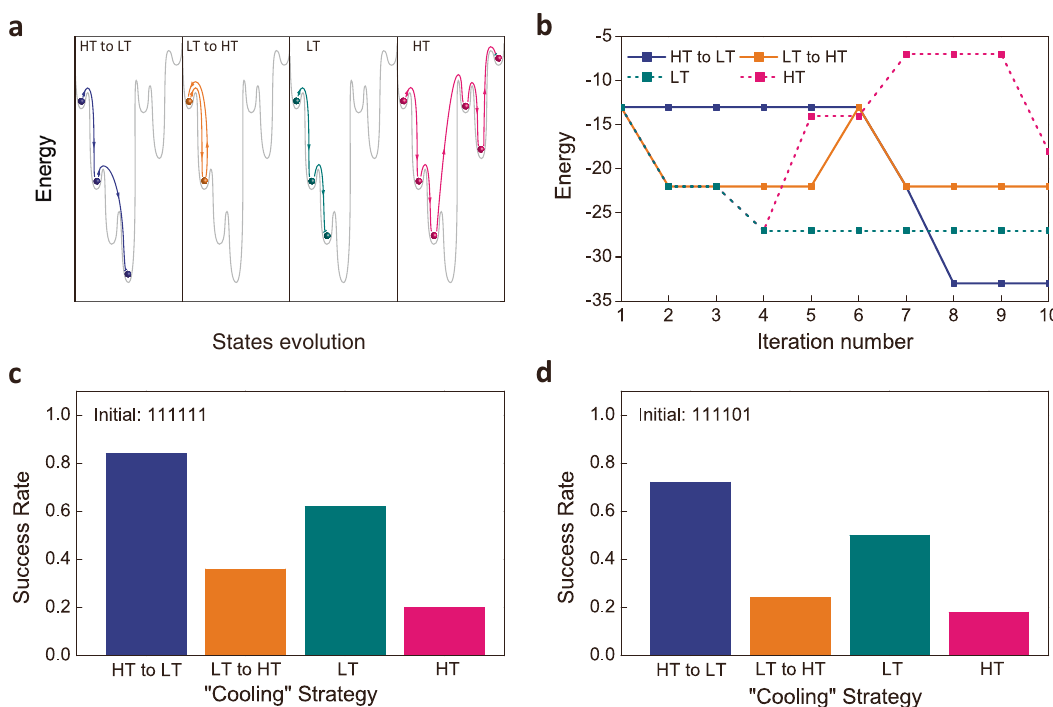
Fig. 4 Implementing the simulated annealing in tin oxide/MoS 2 -based BM. a Conceptual schematic illustrating the evolution of the solution and energy states during the optimization process employing the four different variation strategies. b Experimentally obtained energy evolution in the BM optimization process for the four different strategies. c , d Experimentally extracted success rate of the BM in achieving the most optimal solution using four different strategies of T eff variation during the optimization process: HT to LT, LT to HT, LT, and HT. Different initial states are used in c and d . T eff = 50 for HT and T eff = 5 for LT in b , c and d